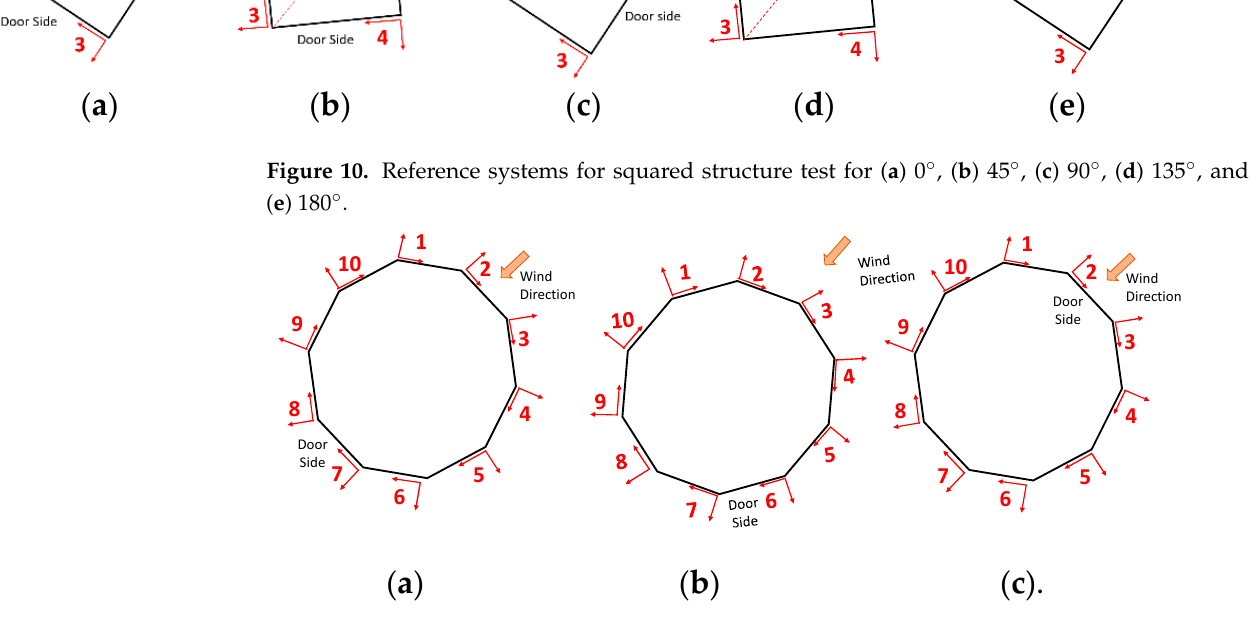
Figure 11. Reference systems for squared structure test for ( a ) 0°, ( b ) 45°, and ( c ) 180°. By looking at the results in Figures 7 and 8, it is possible to observe the symmetry between sides 1 and 2 in Figure 8, by noting the reference systems used to compute displacements for sides 1 and 2 in Figure 9. To observe this symmetry, one of the two graphs of the two sides should be flipped with respect to the center of the horizontal axis (length of the side). Regarding Figure 8, a symmetry can be observed between sides 1 and 3 with a reversed horizontal axis of side 1 or of side 3, since the reference systems are placed as in the scheme of Figure